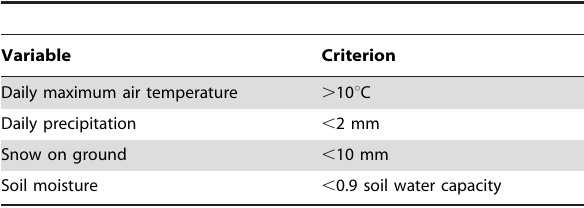
Table 2. Criteria used in estimating seeding dates of spring